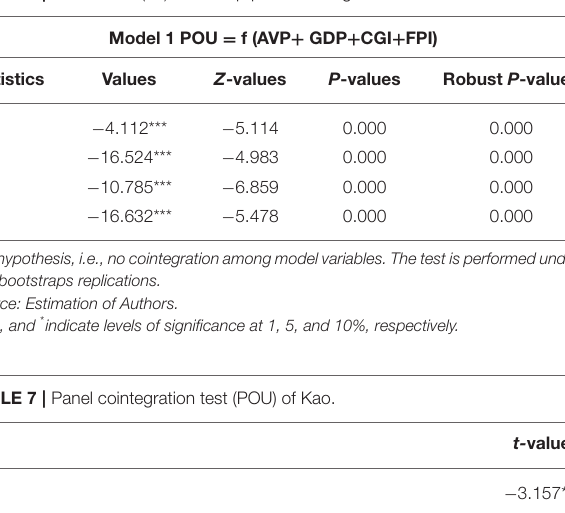
TABLE 6 | Westerlund (40) bootstrap panel cointegration test.